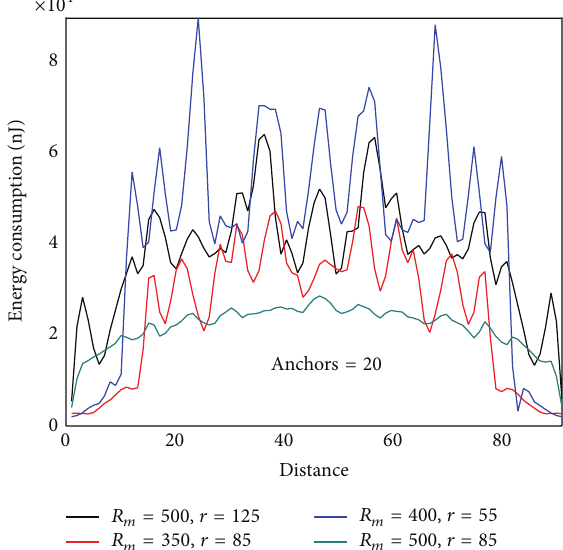
Figure 33: Energy consumption after combining 𝑟 and 𝑅 𝑚 (experimental value).